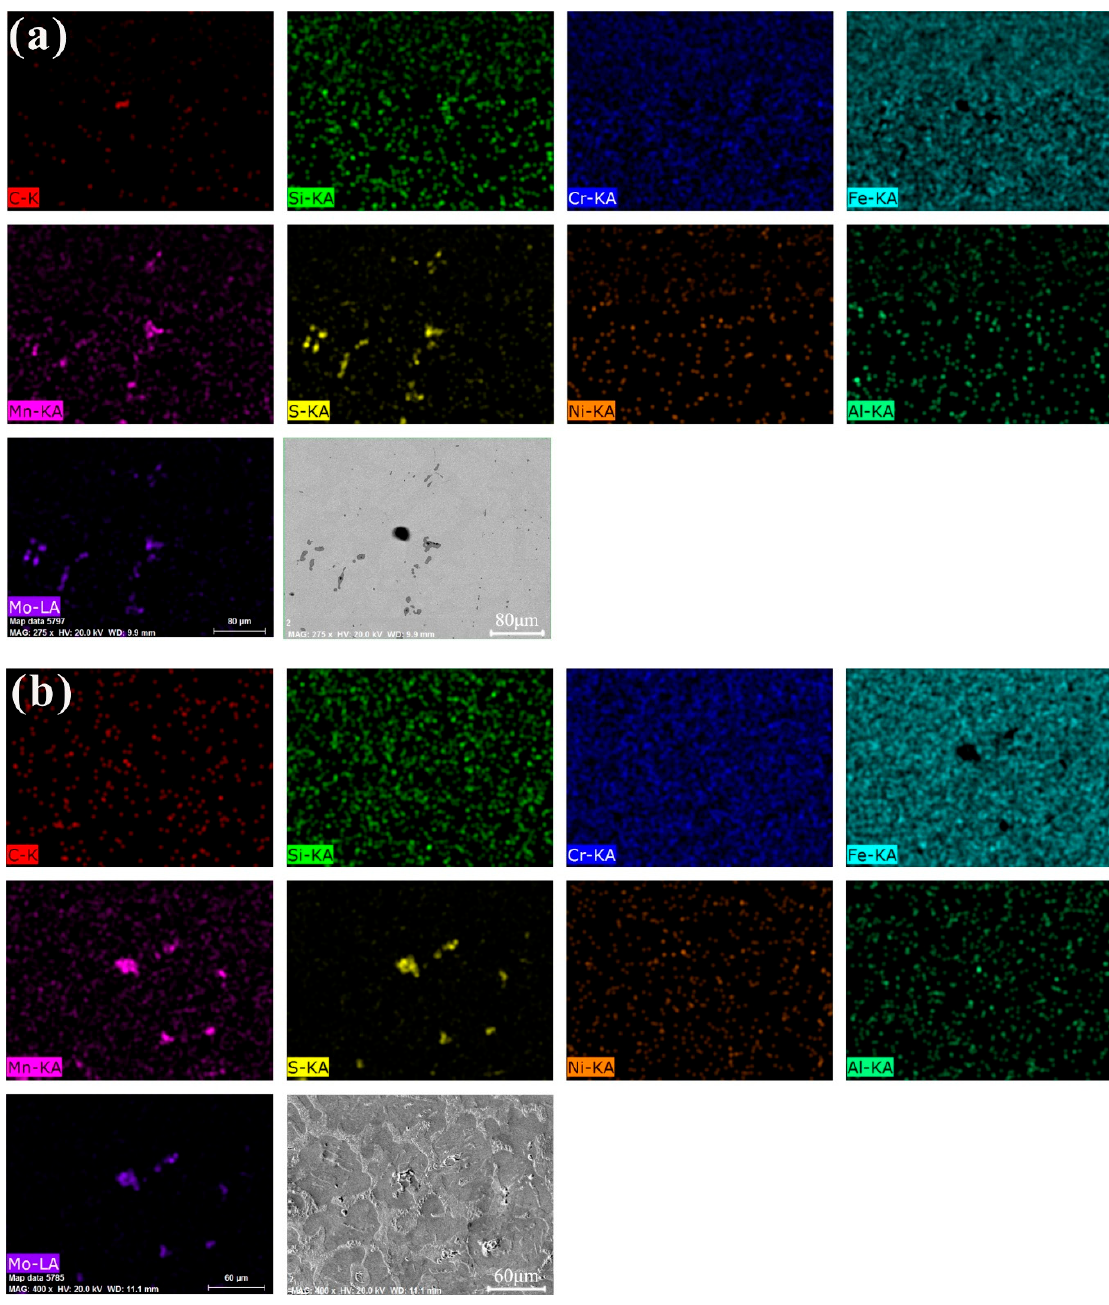
Figure 7. Distribution of chemical elements in 1Cr13MoS obtained by EDS: ( a ) sample was not corroded (Acceleration voltage: 20 kV, Working distance: 11.1 mm), ( b ) sample was corroded by ferric chloride hydrochloride solution (Acceleration voltage: 20 kV, Working distance: 9.9 mm).